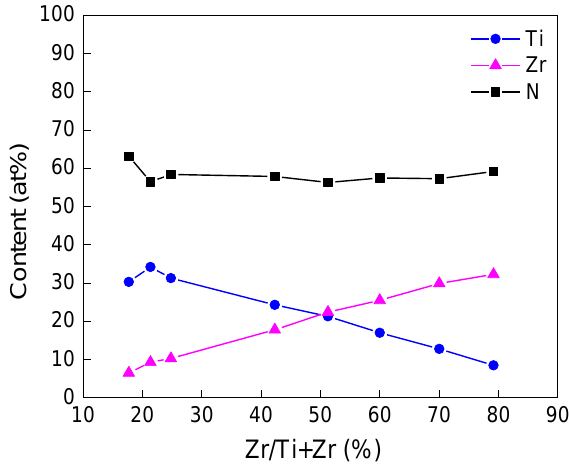
Figure 2. Chemical composition of the surface of the films.